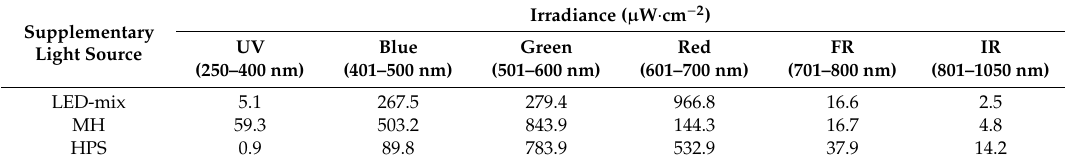
Table 1. The irradiance distributions of the supplementary light sources: LED-mix, mixed (red: blue: white = 6:1:1) light-emitting diodes; MH, metal halide lamps; and HPS, high-pressure sodium lamps.